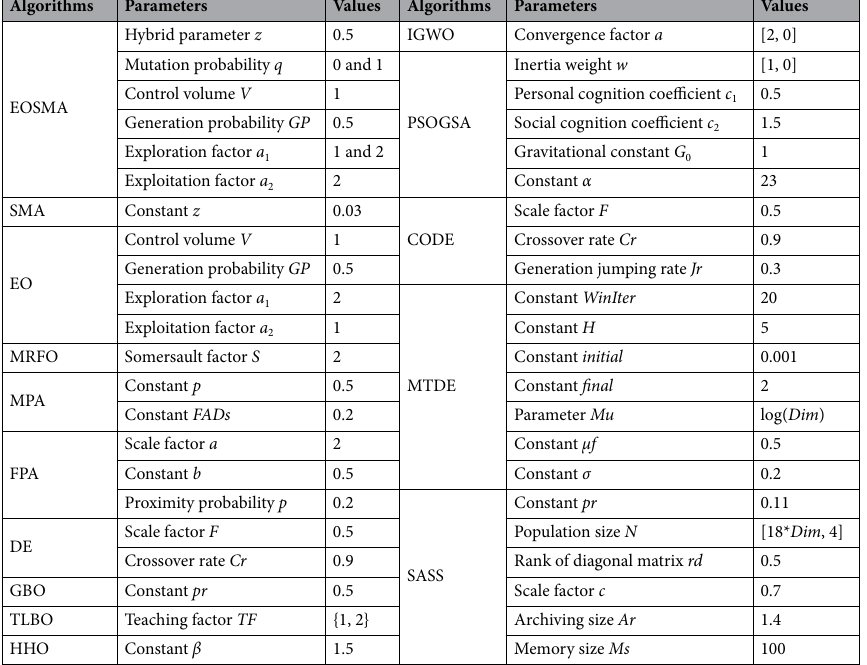
Table 3. Parameter settings of the single-objective algorithms. For scenario 1, N = 50, Max_t = 500; For scenario 2, N = 100, Max_t = 1000.